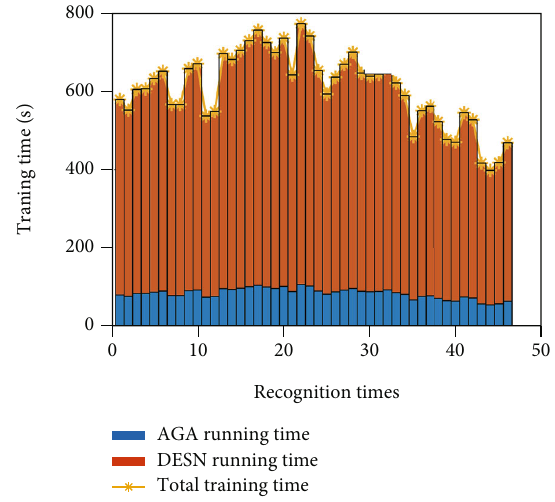
Figure 17: Training time of AGADESN algorithm.